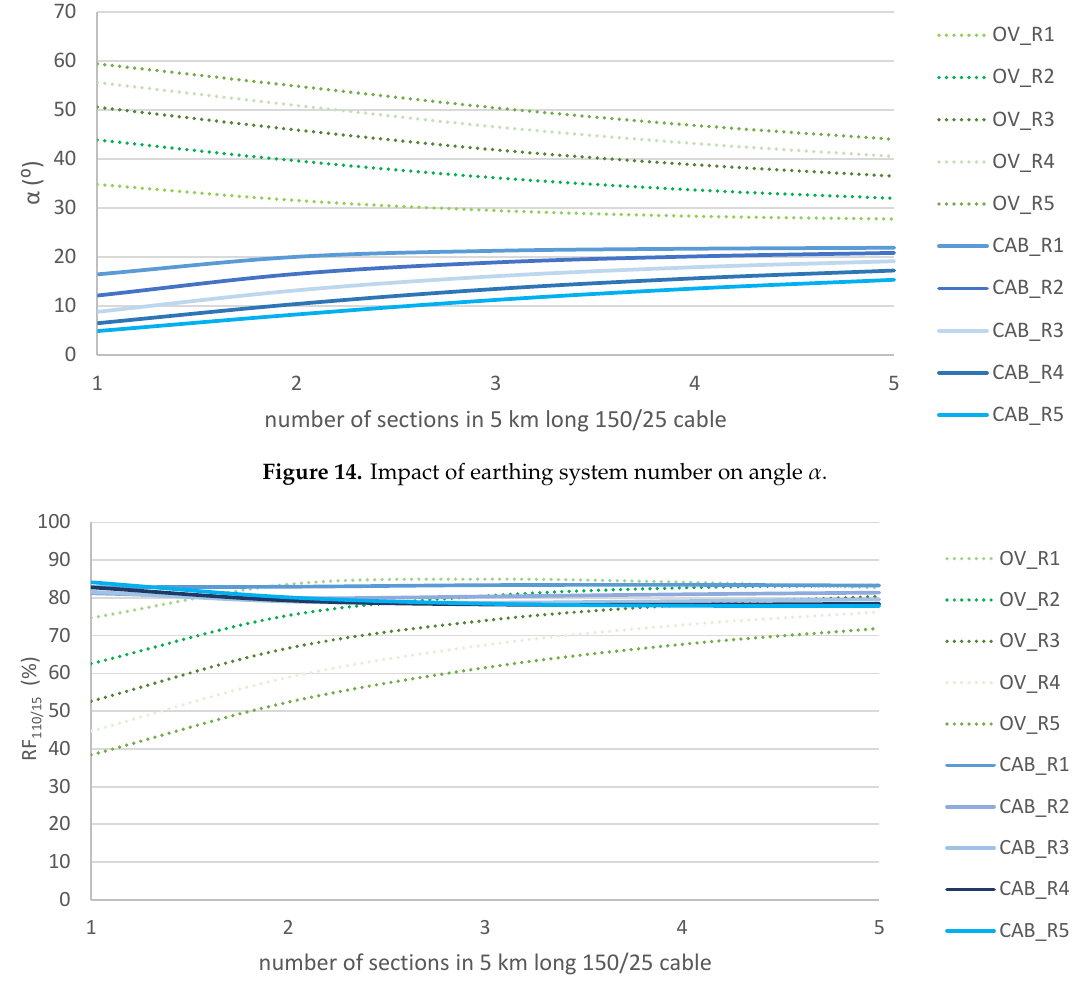
Figure 15. Impact of earthing system number on RF 110/15 .